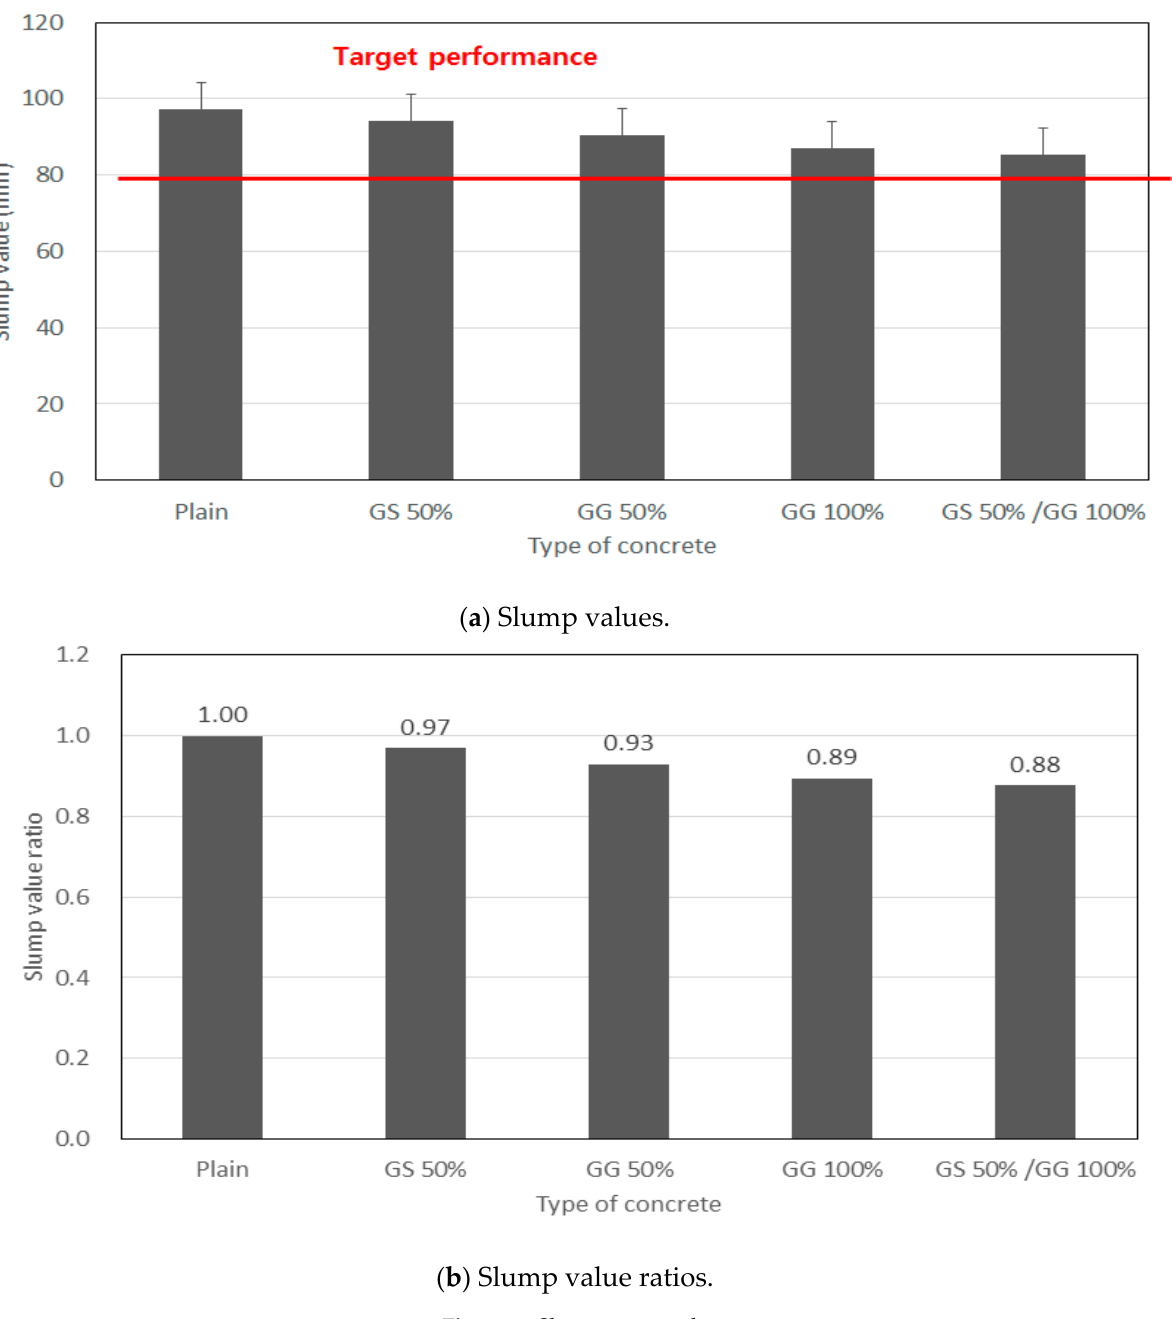
Figure 2. Slump test results.